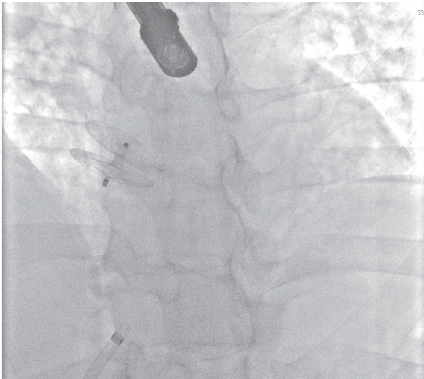
Figure 2: Patent foramen ovale occlusion device positioned appro- priately across atrial septum after release.